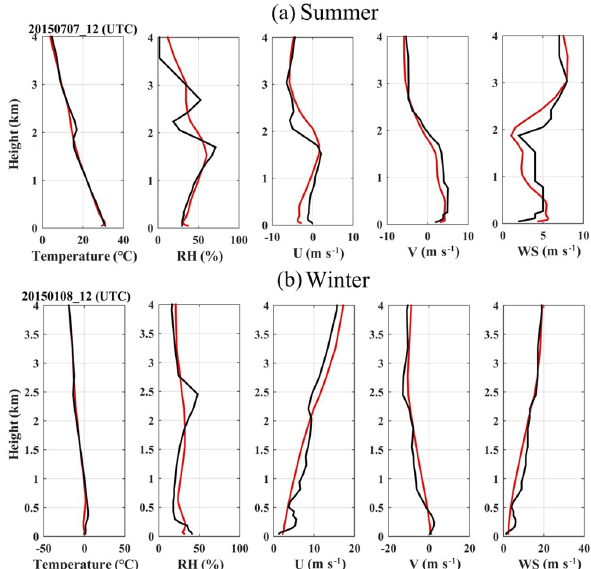
Figure 11. Vertical profiles of temperature (unit: ◦ C), RH (unit: %), U -wind speed ( U ; unit: ms − 1 ), V -wind speed ( V ; unit: ms − 1 ), and wind speed (WS; unit: ms − 1 ) at (a) 12:00UTC on 8 July 2015 and (b) 12:00UTC on 7 January 2015. Red lines are simulation results, and black lines are observations.